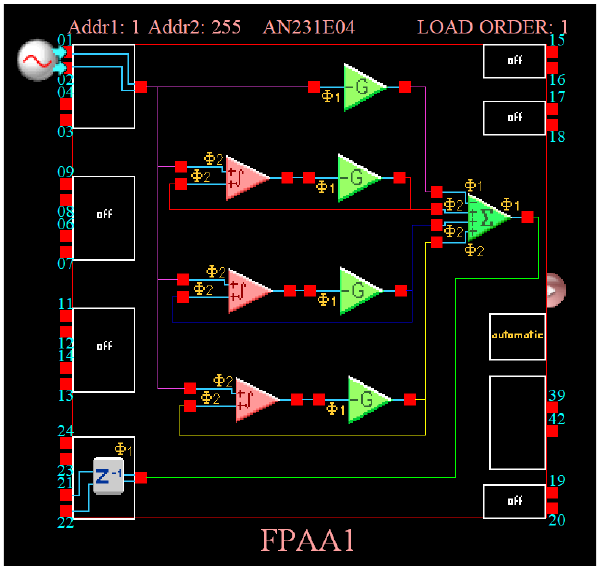
Figure 4. FPAA-based realization of the transfer function in (15).